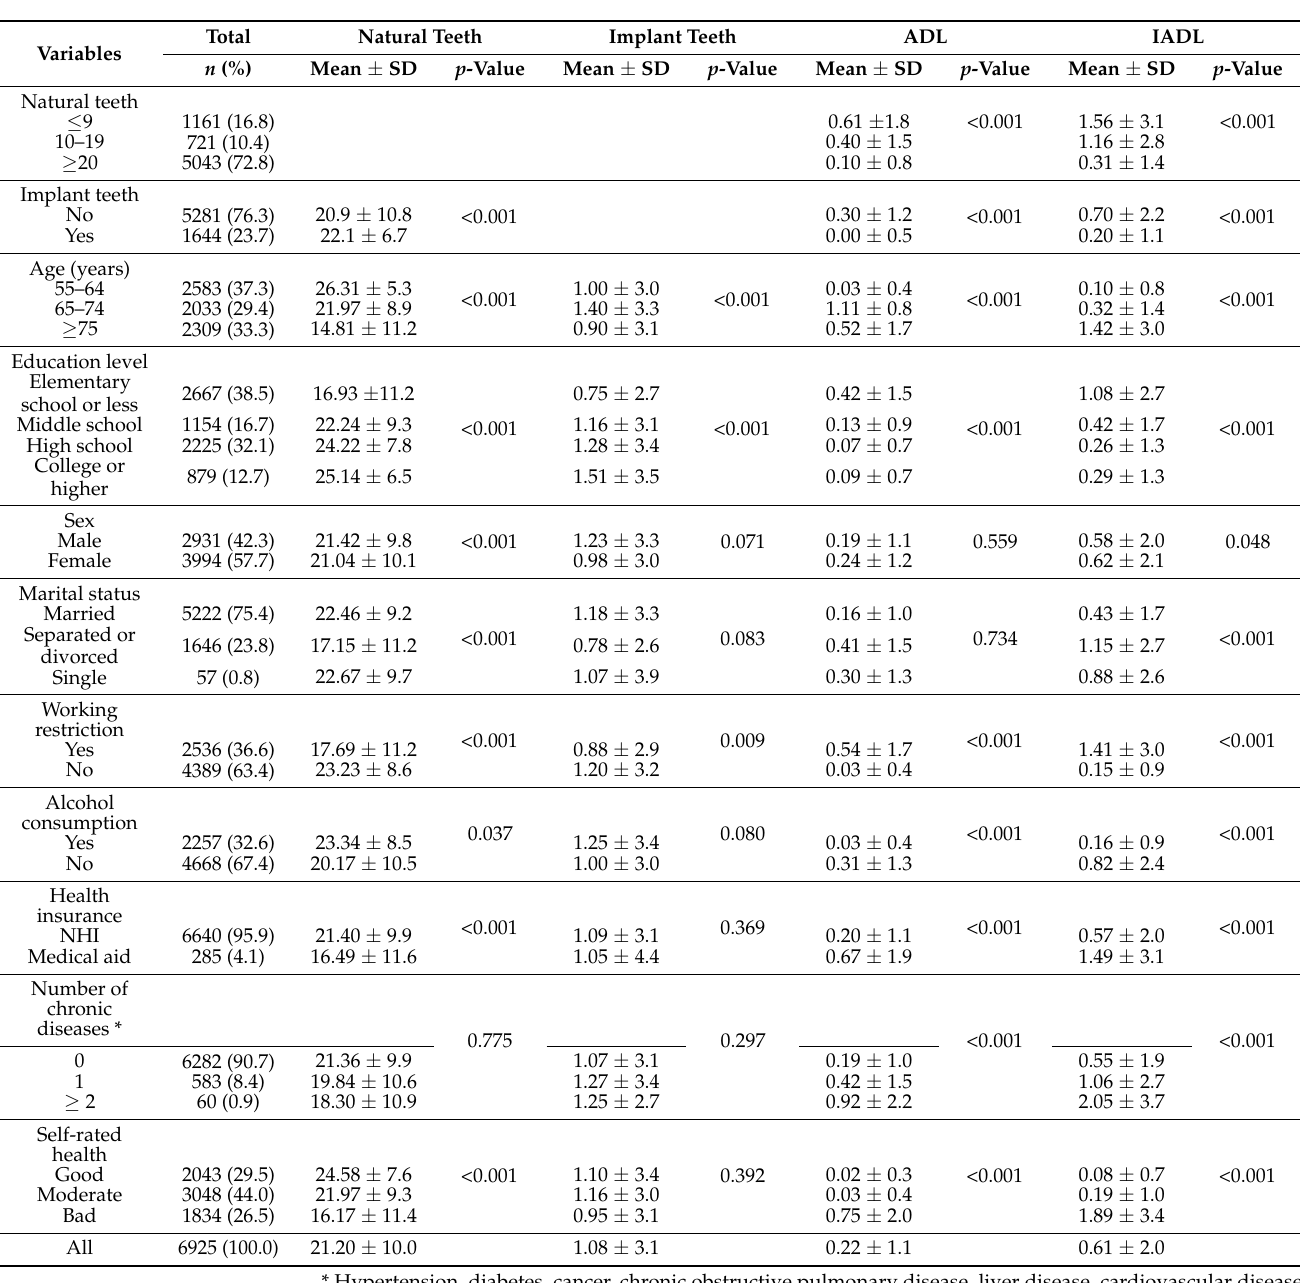
Table 1. General characteristics of the participants at